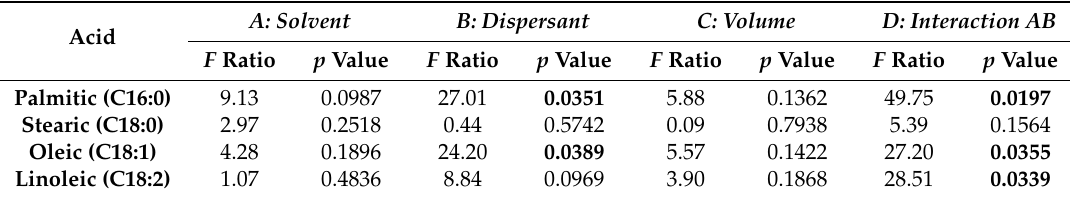
Table 3. Analysis of variance (ANOVA) table showing the significance of main effects and second order interactions ( F ratios and p